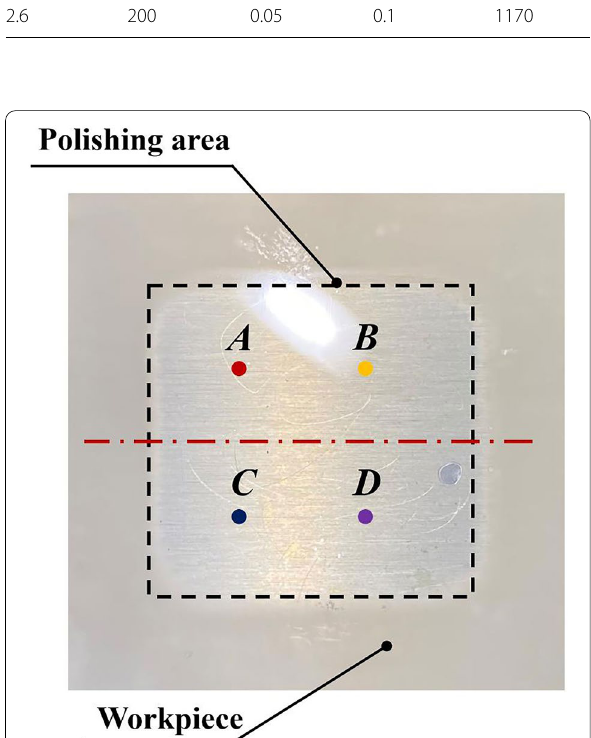
Figure 8 Optical component after